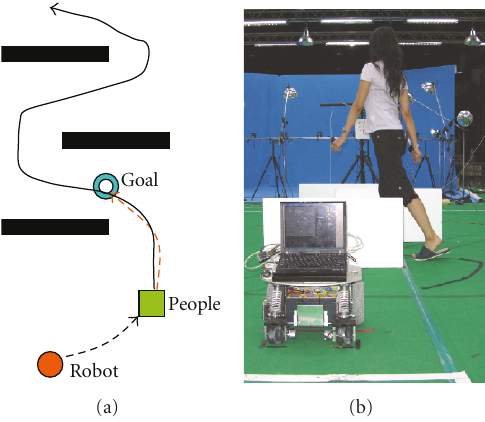
Figure 10: Environment setup of the localization and POMOT experiment. (a) People trajectory. (b) Experimental